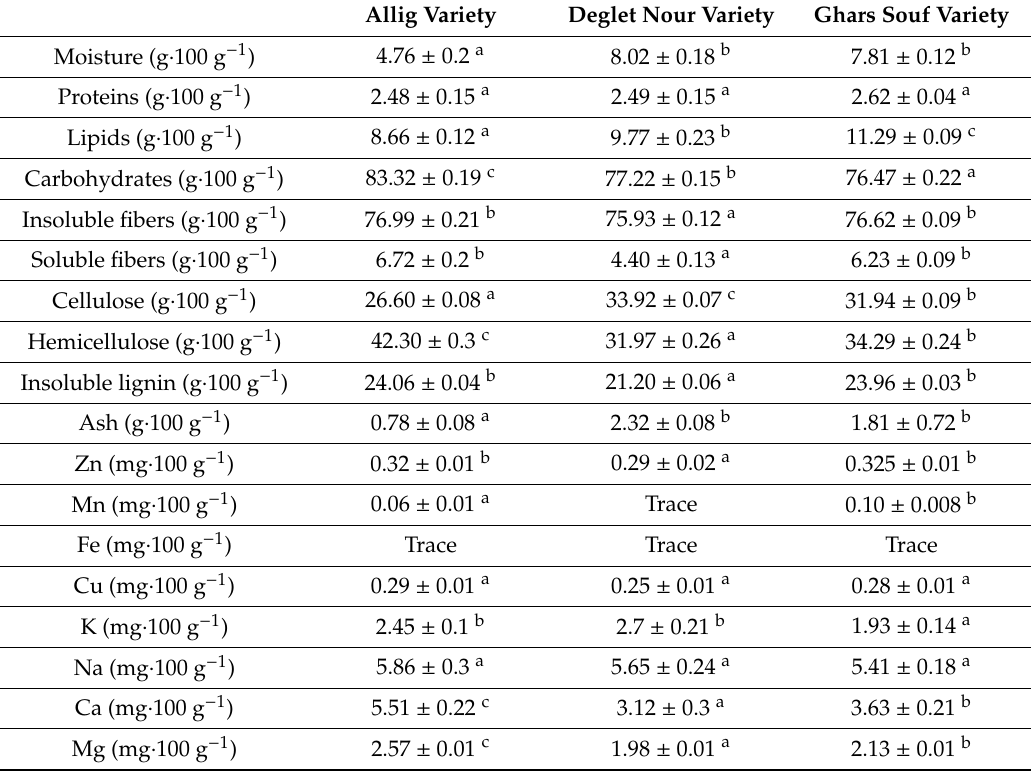
Table 1. Chemical composition of the three date seeds varieties of Allig, Deglet Nour, and Ghars Souf. Allig Variety Deglet Nour